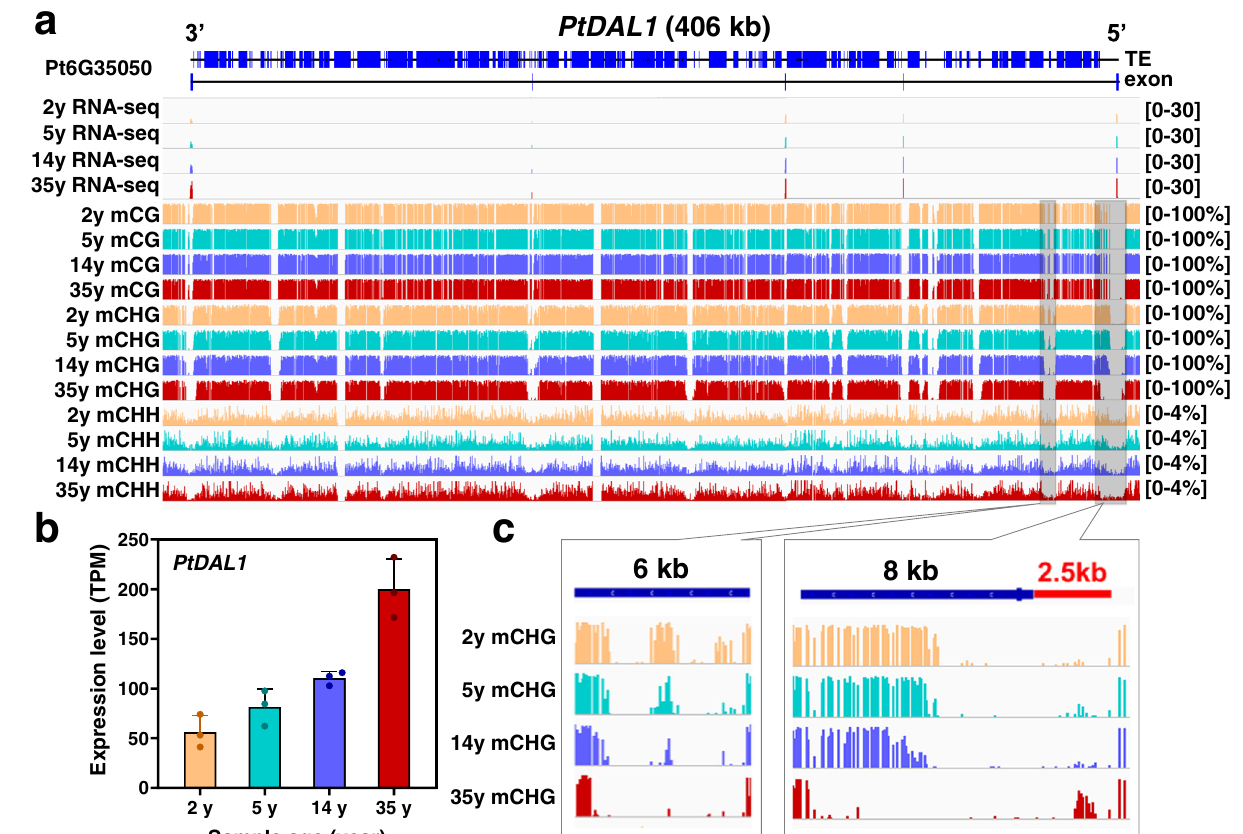
Fig. 5 | DNA methylation dynamic associated with the age timer DAL1 age- related expression. a The DNA methylation patterns of PtDAL1 in four age stages. b The expression of PtDAL1 at 2, 5, 14, and 35 years. Data were presented